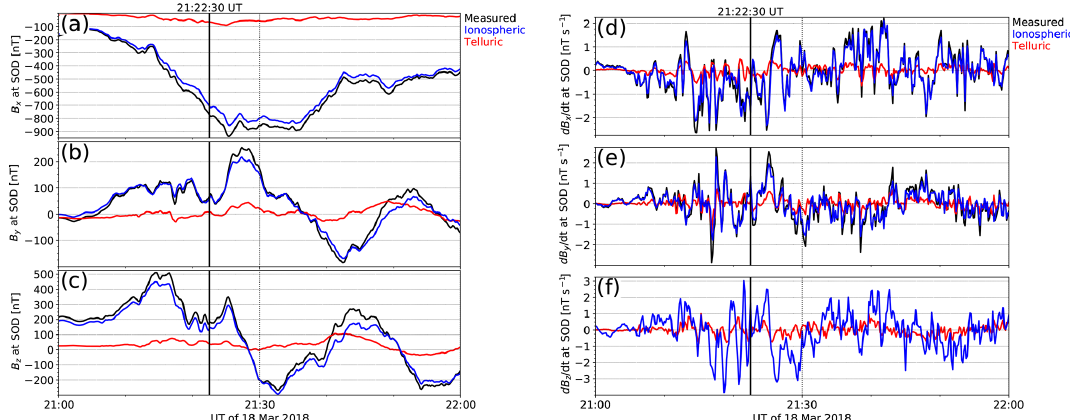
Figure 9. Magnetic field at SOD in the same format as Fig. 4, except that the external, instead of the real, measured ground magnetic field has been given as input to the SECS field separation. “Measured” refers to the external magnetic field from the original analysis, “Ionospheric” to the external magnetic field from the reanalysis, and “Telluric” to the internal magnetic field from the reanalysis.